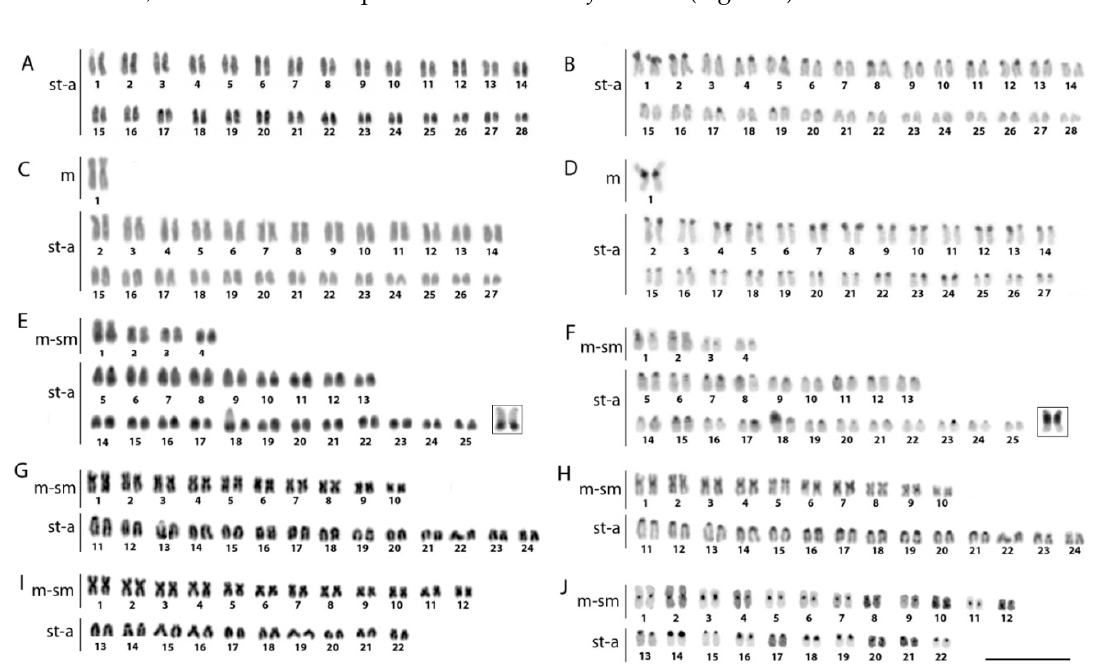
Figure 3. Karyotypes of the silver arowana Osteoglossum bicirrhosum ( A , B ), black arowana Osteoglossum ferreirai ( C , D ), Asian arowana Scleropages formosus ( E , F ); northern saratoga Scleropages jardinii ( G , H ) and southern saratoga Scleropages leichardti ( I , J ) arranged from Giemsa-stained ( A , C , E , G , I ) and C-banded chromosomes ( B , D , F , H , J ). In boxes ( E , F ), the variant forms of the 18th chromosome pair of Asian arowana in relation to its C-positive heterochromatin content (for more details, please check Section 3.2 in the discussion section) Bar = 5 µm.